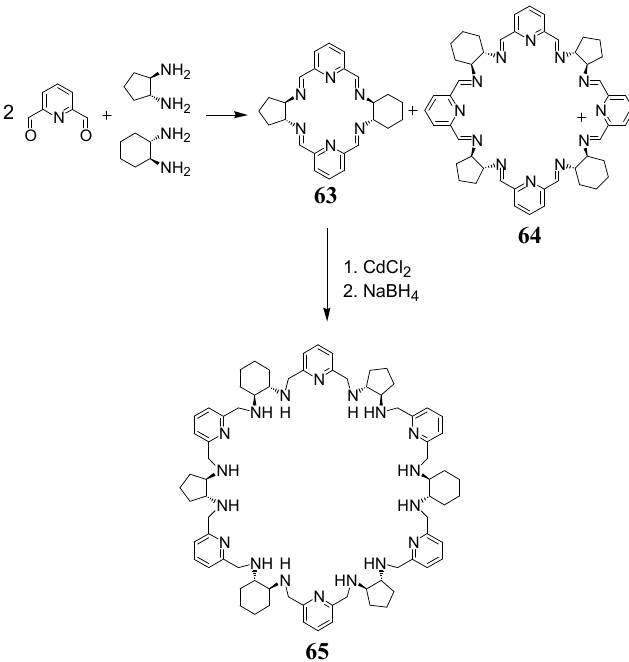
Figure 32. Macrocycles containing DACH and DACP rings.